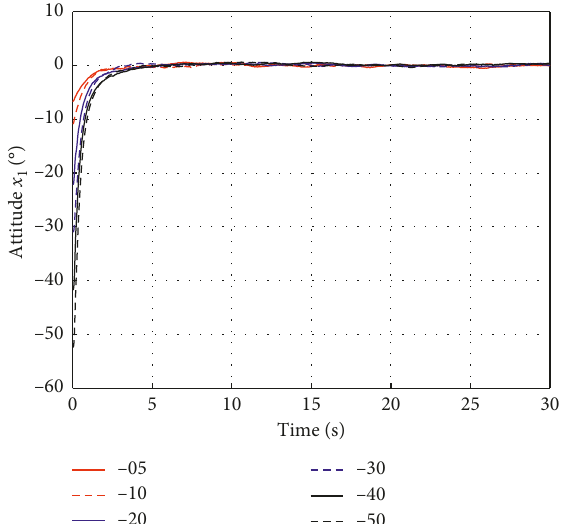
Figure 7: Time response of the attitude x ( ii ) .